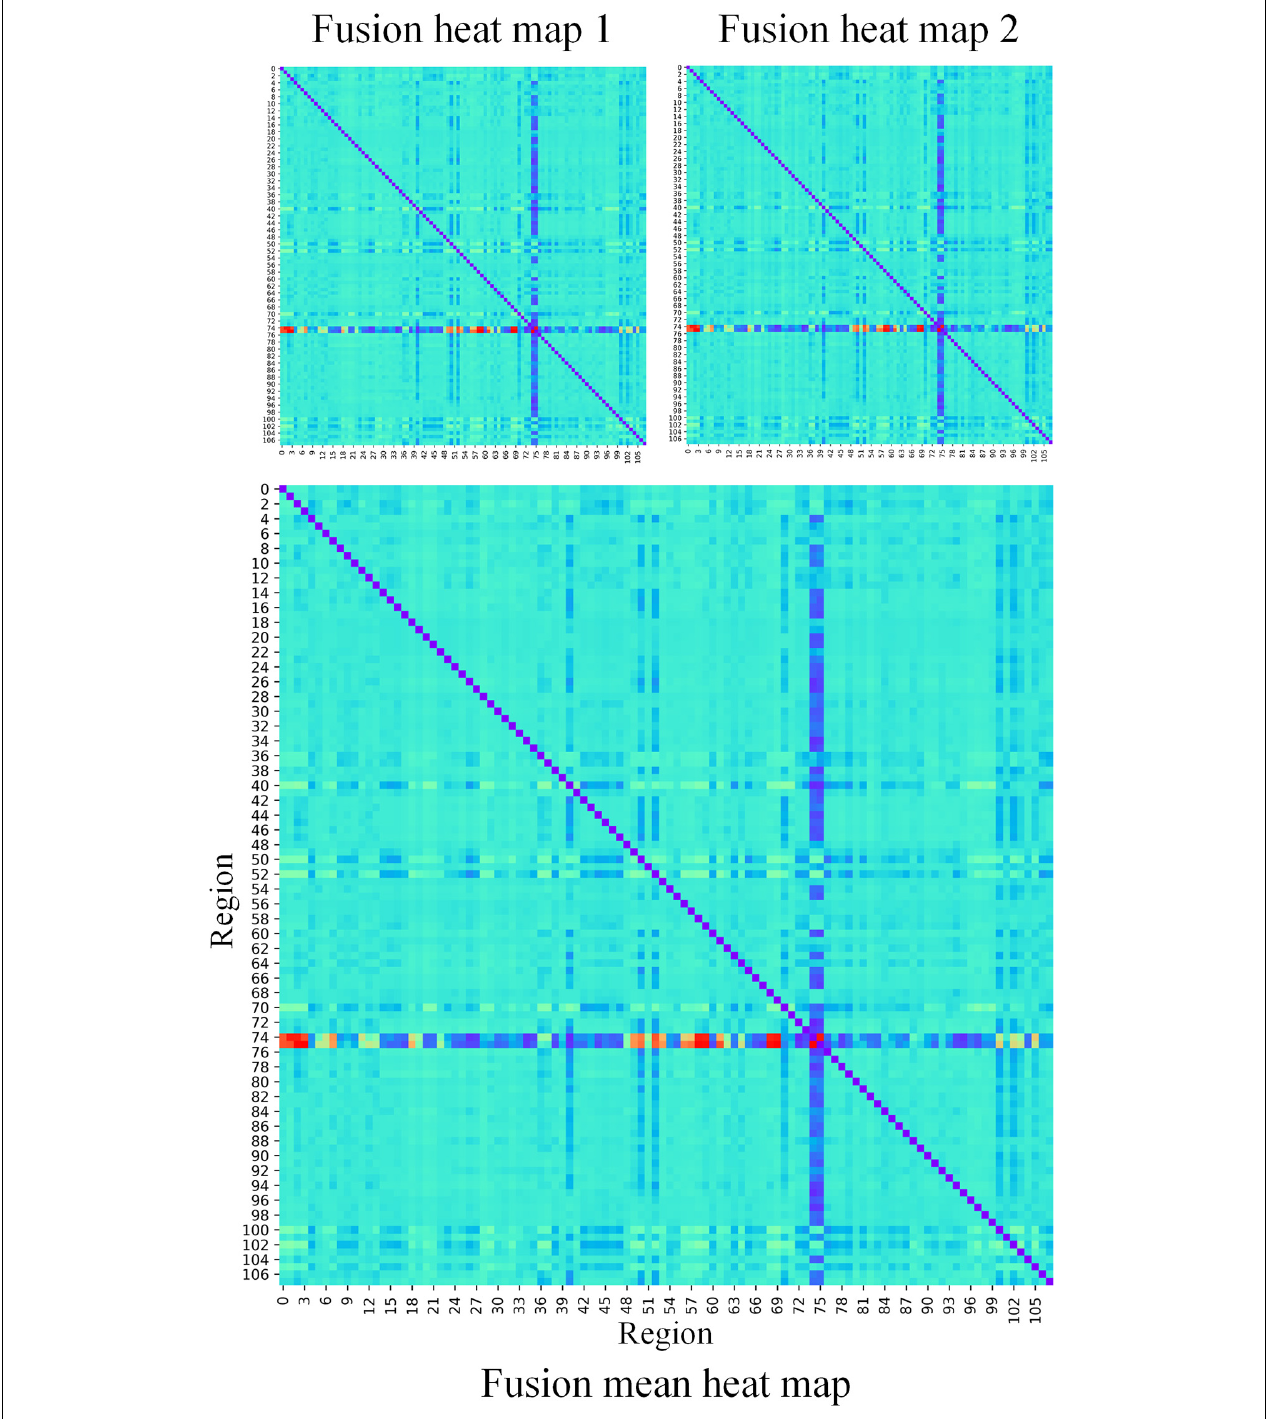
FIGURE 5 | The fusion heat maps obtained by the average heat maps of all true negative subjects. The redder the color is, the more contributions the brain region